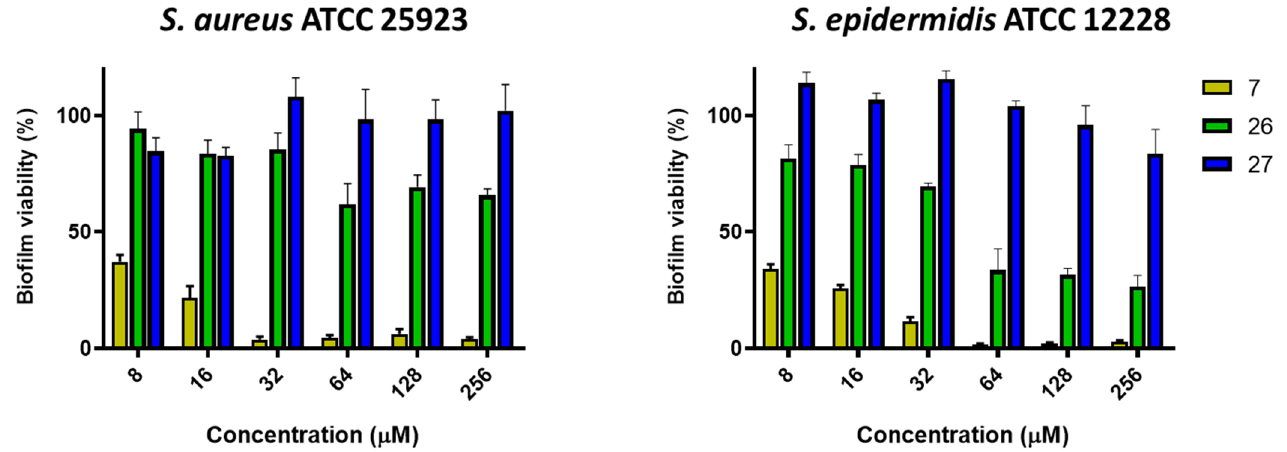
Figure 2. Activity of compounds 7 , 26 , and 27 against preformed S. aureus and S. epidermidis biofilms, evaluated after 2 h of treatment, compared to the untreated control cells, using the MTT assay. The values are the means ± SEM of triplicates of three independent experiments.